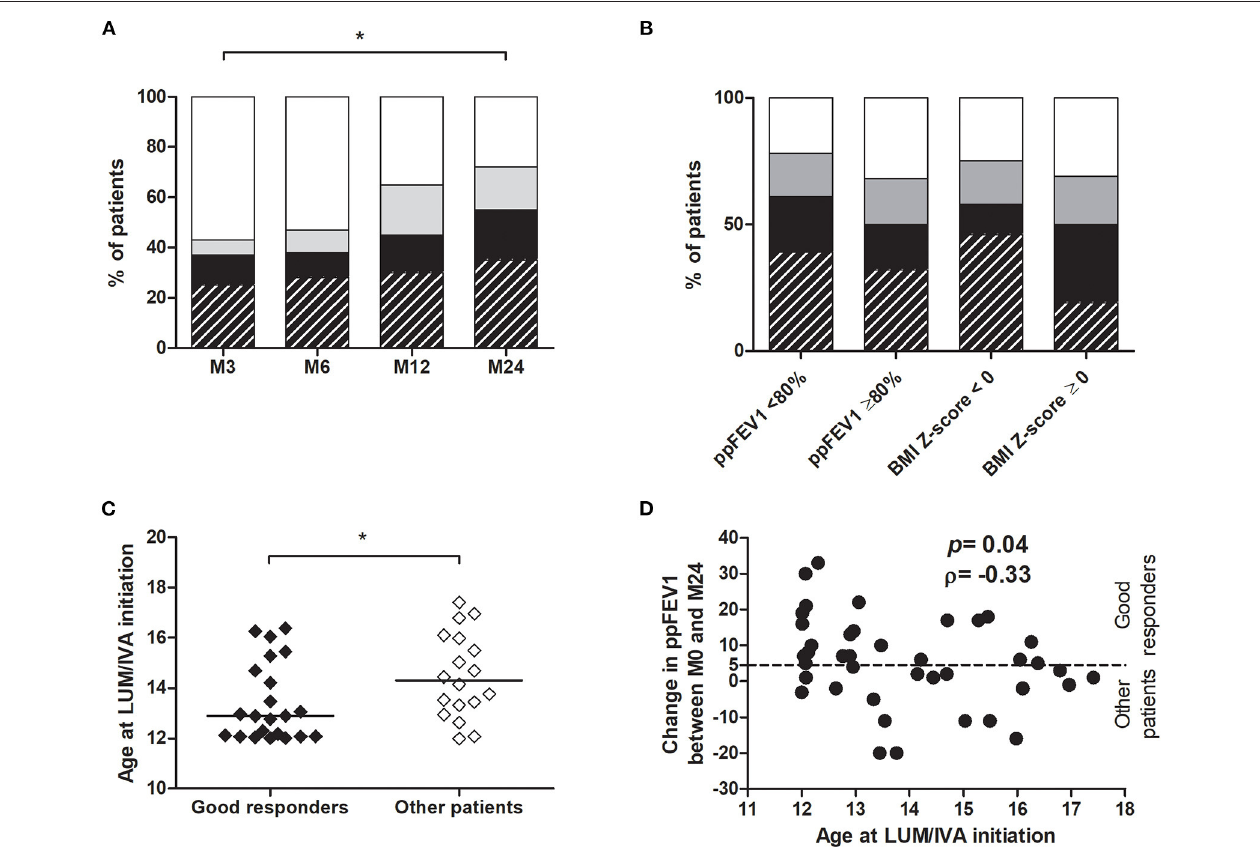
FIGURE 6 | Evaluation of LUM/IVA treatment response over time and factors associated with a good response. For each time point, responses of patients were evaluated by the ppFEV1 change at the time point compared with M0 (A,B) . Patients with a good response to treatment (ppFEV1 change ≥ 5%) are represented in hatched black (ppFEV1 change > 10%) or black (ppFEV1 change > 5%), those in the no decline group (ppFEV1 change between 0 and 5%) in gray and the low/non responders (ppFEV1 decline) in white (A,B) . Comparisons between good responders (hatched black and black) and other patients at 3 (M3), 6 (M6), 12 (M12), and 24 months (M24) after LUM/IVA initiation was performed using the Chi-square test (A,B) . Age at initiation of LUM/IVA was compared between good responders, defined by their ppFEV1 change > 5% at M24, and other patients (no decline group + low/non responders) (C) . Comparisons between groups were performed using the Mann–Whitney test. *Indicates p < 0.05. Correlation between age at LUM/IVA initiation and ppFEV1 change between LUM/IVA initiation (M0) and 24 months after initiation (M24) from all patients (D) was performed using the Spearman test and the coefficient of correlation ρ is